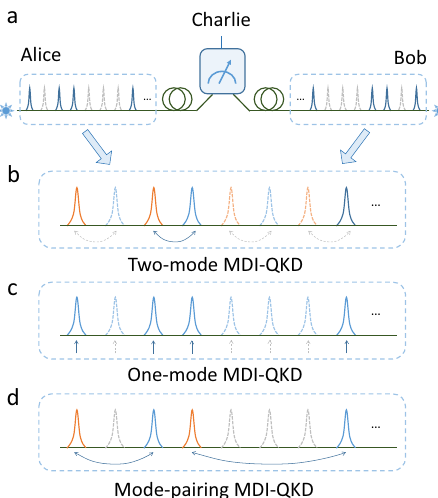
Fig. 1 Comparison of two-mode, one-mode and mode-pairing MDI-QKD schemes. a Schematic diagram of a generic MDI-QKD scheme. The solid and dashed pulses yield successful and unsuccessful detection, respectively, at the measurement site. For b , c and d , each wave packet in the diagram represents two independent pulses emitted simultaneously by Alice and Bob. b In two-mode MDI-QKD schemes, the pairing of the blue pulses (as phase references) and orange pulses (as signals) is predetermined, necessitating coincidence detection. c In one-mode MDI- QKD schemes (e.g., twin- fi eld quantum key distribution and its variants), there is no phase reference pulse, necessitating global phase locking. d In the mode-pairing MDI-QKD scheme, in accordance with the detection results, Alice and Bob pair the clicked pulses and assign them to be either reference or signal pulses, such that neither coincidence detection nor global phase locking is